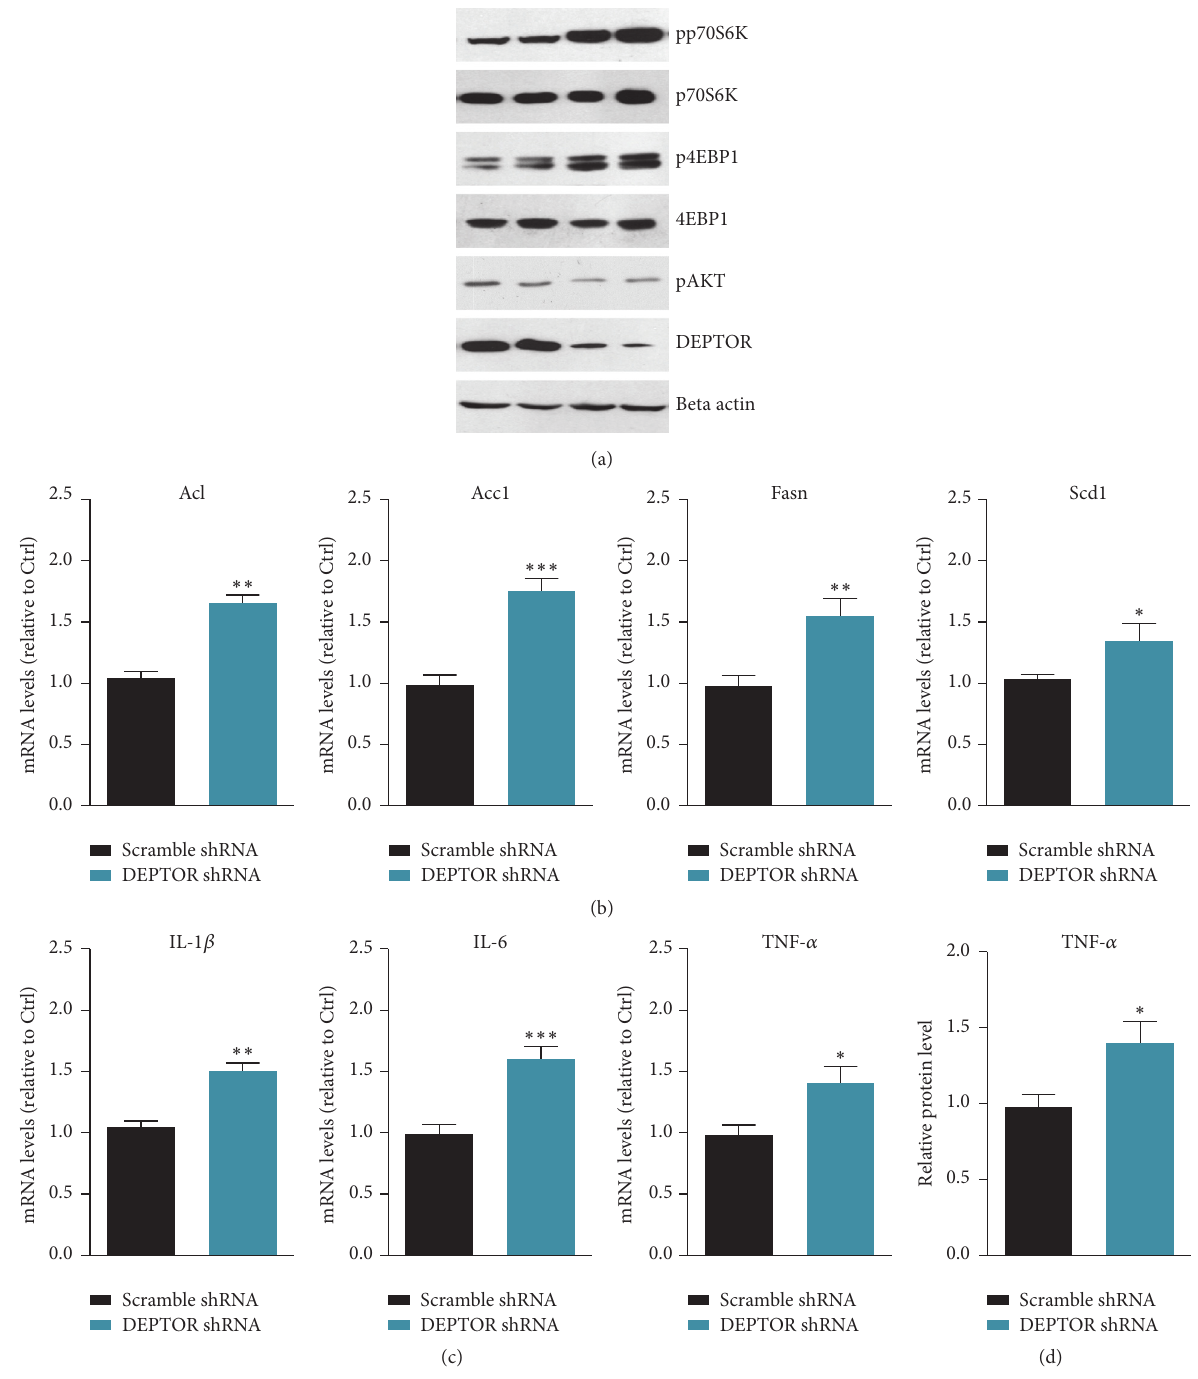
Figure 4: DEPTOR knockdown increases mTORC1 activity, lipogenesis, and inflammation in lymphocytes of PBMC culture. (a) Western blots showed that mTORC1 activity, indicated by phosphorylations of p70S6K and 4EBP1, was upregulated by DEPTOR shRNA in lymphocytes of PBMC culture. Noted that pAKT was slightly downregulated by DEPTOR knockdown. (b) Real-time RCR results showed that mRNA levels of lipogenesis genes, including Acl, Acc1, Fasn, and Scd1, were increased in DEPTOR knockdown cells. Results are averages of three independent experiments. Data represent mean ± SEM. ∗ 𝑃 < 0.05 , ∗∗ 𝑃 < 0.01 , and ∗∗∗ 𝑃 < 0.001 . (c) Real-time RCR results showed that mRNA levels of inflammation genes, including IL1- 𝛽 , IL-6, and TNF- 𝛼 , were increased in DEPTOR knockdown cells. Results are averages of three independent experiments. Data represent mean ± SEM. ∗ 𝑃 < 0.05 , ∗∗ 𝑃 < 0.01 , and ∗∗∗ 𝑃 < 0.001 . (d) ELISA results showed that protein level of TNF- 𝛼 was increased in DEPTOR knockdown cells. Results are averages of three independent experiments. Data represent mean ± SEM. ∗ 𝑃 < 0.05